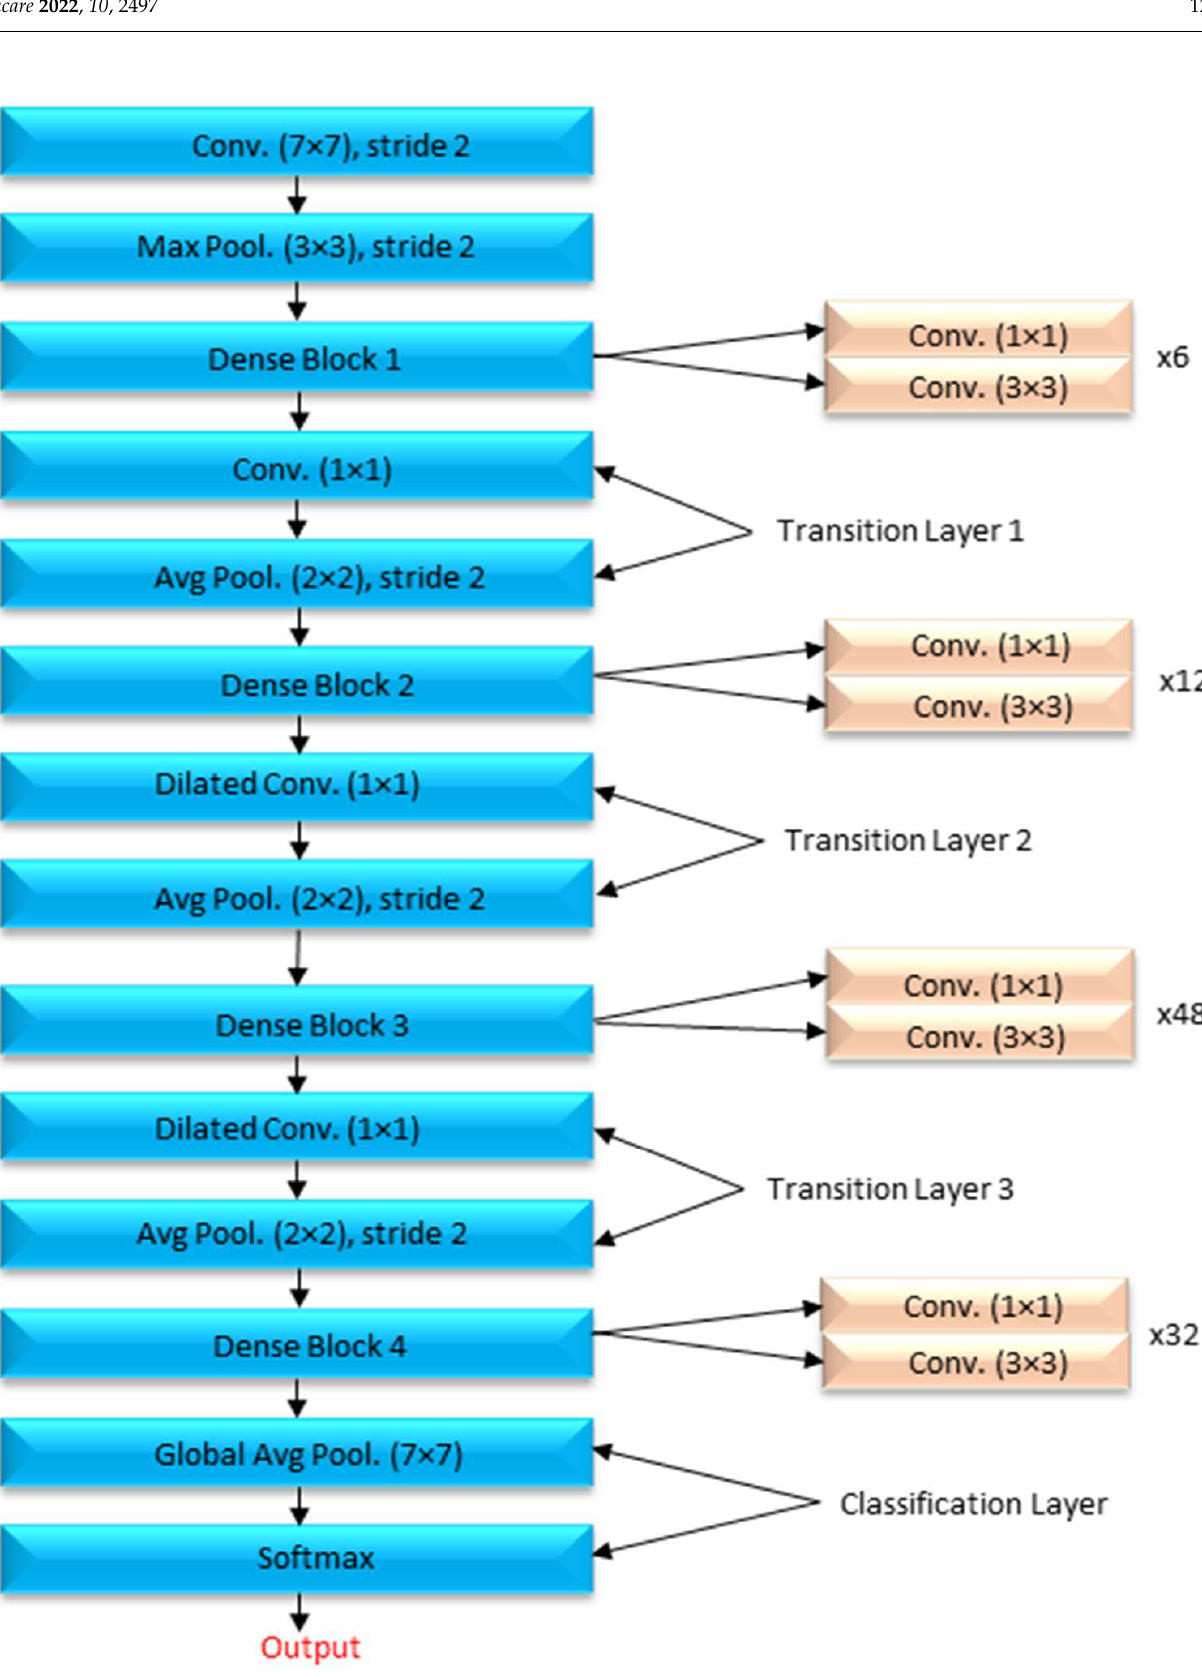
96.45 Table 3. Evaluation of the effectiveness of recall. Models